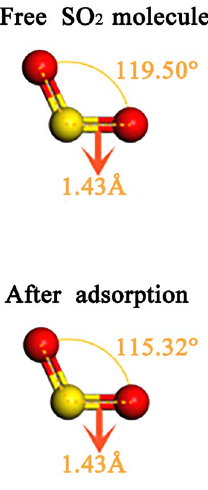
Figure 5. The structure of SO 2 free and after